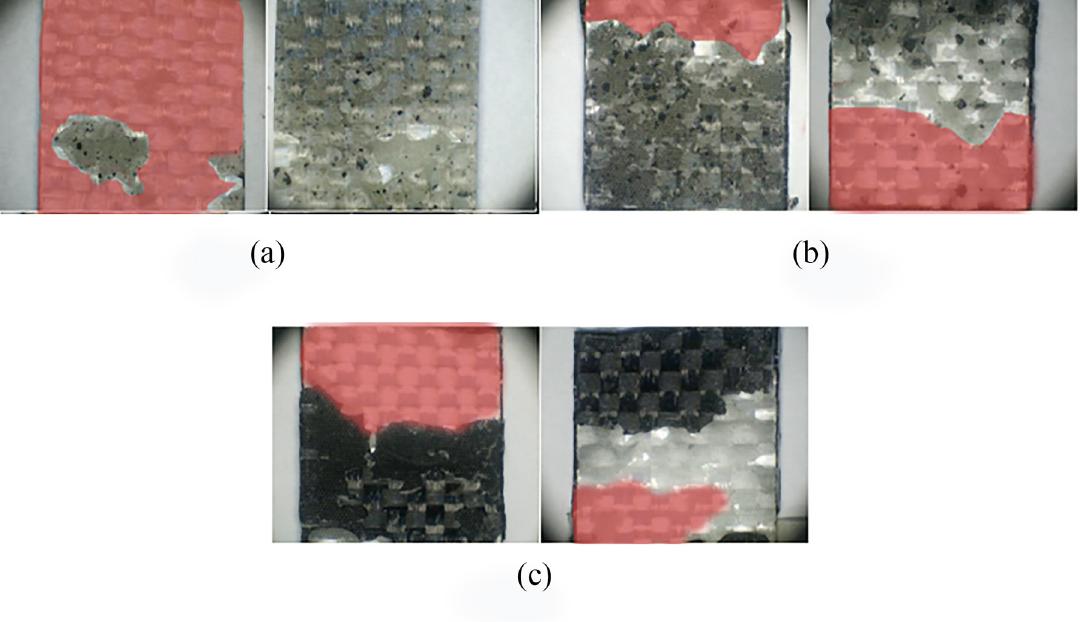
A00-005. According Budhe et al. 33 , this behavior could be related to two main factors: redistribution of stress inside the adhesive layer and the number of internal defects, such voids, which increases with the adhesive layer.